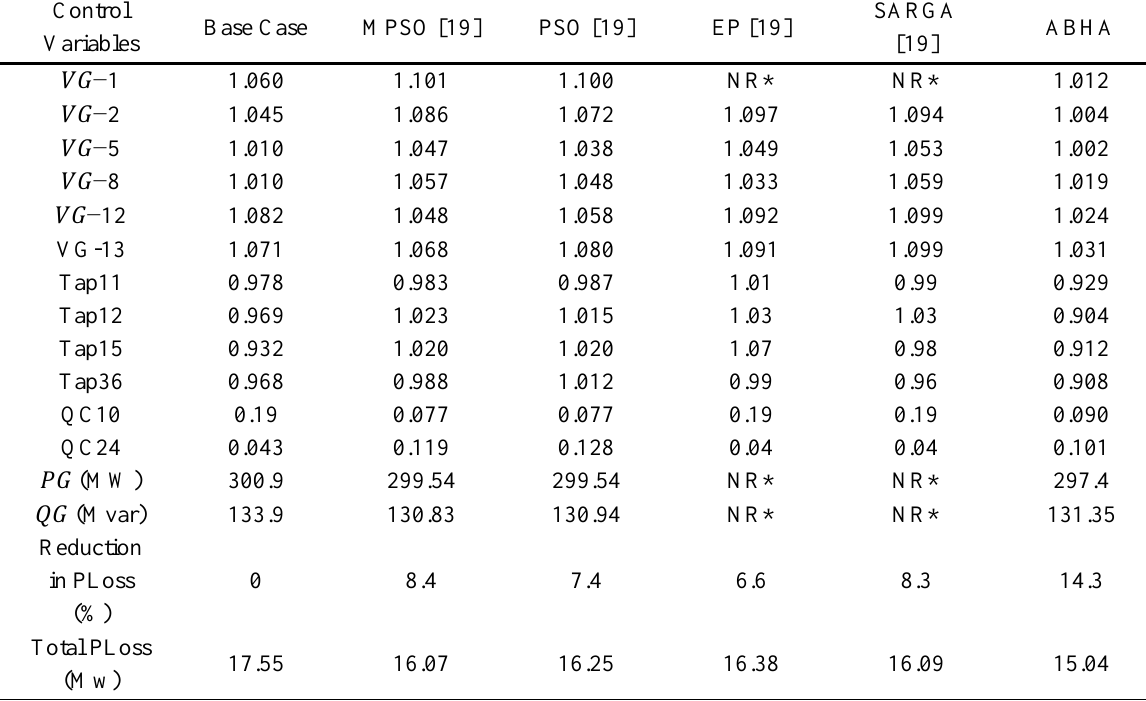
Table 6. Simulation results of IEEE −30